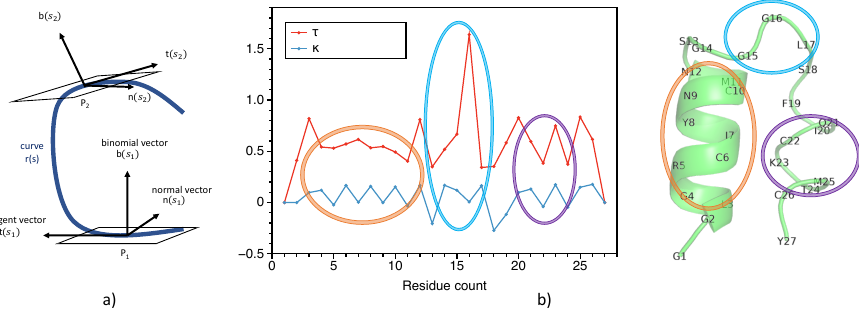
Figure 1. ( a ) The tangent vector t , normal vector n , and the binormal vector b of a Frenet frame at points P 1 and P 2 , respectively, for a curve r ( s ) . ( b ) Representation of protein backbone in terms of scalar curvature κ and torsion τ , respectively. The ideal helix, turn, and non-ideal helix is shown in orange, cyan, and magenta, respectively. The curvature and torsion pattern captures the secondary structure of the